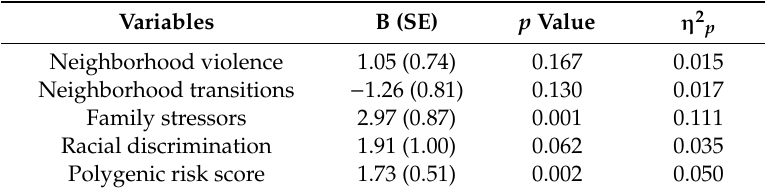
Table 2. Main e ff ects model for neighborhood and social network stressors and genetic risk on externalizing behaviors in African American adolescent drinkers ( n =